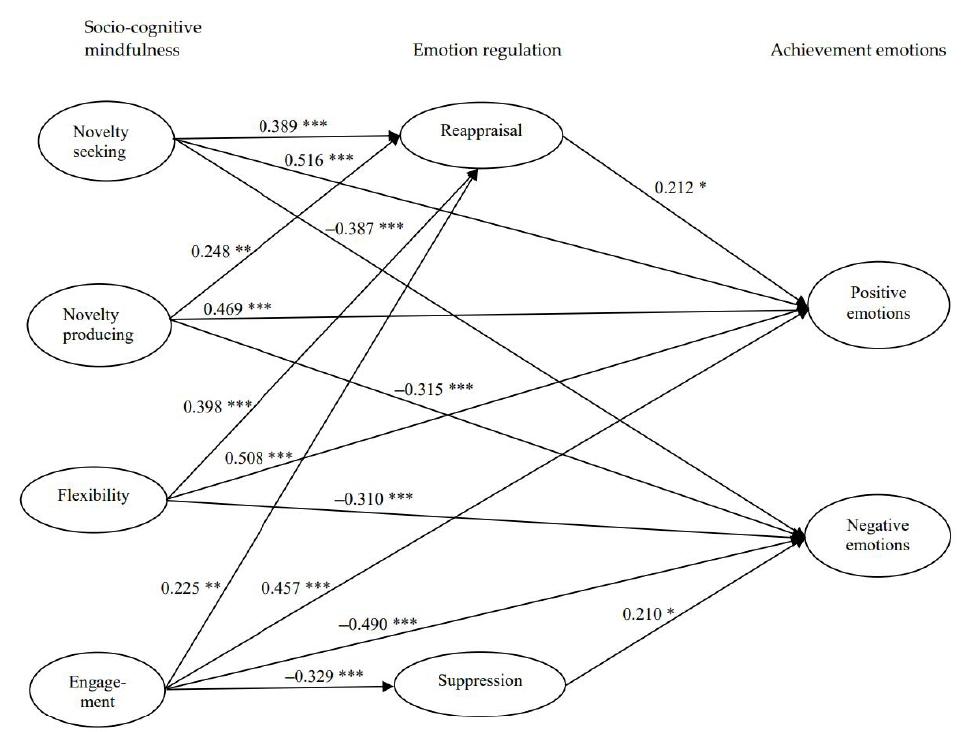
Figure 1. Structural parameter estimates for effects of socio-cognitive mindfulness on nursing students’ emotion regulation and achievement emotions. Only significant coefficients are displayed. *